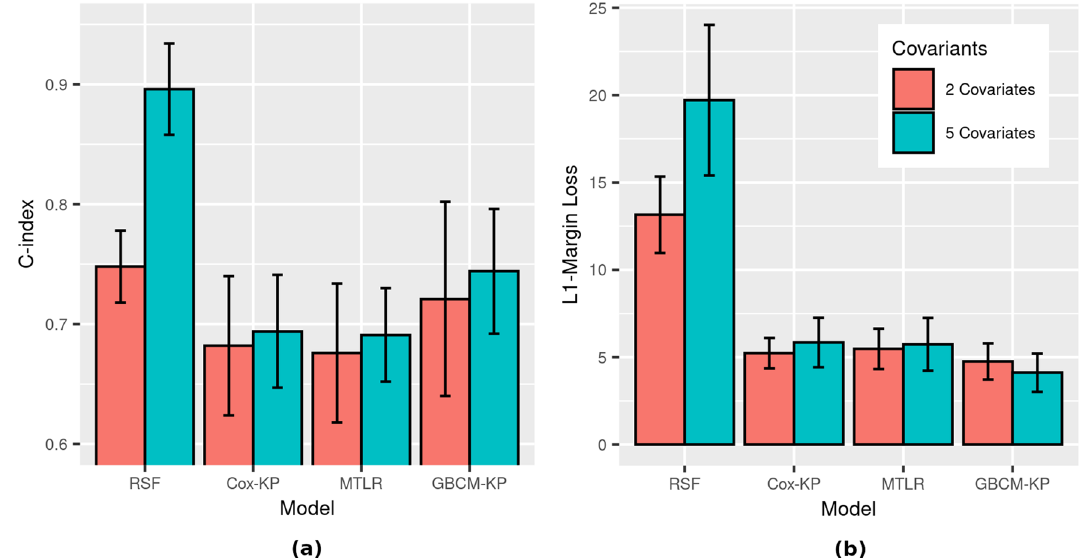
Figure 4. Survival prediction performance on dataset D2[h] (N = 1718) for hospital discharge as event of interest using two covariates (age, sex) versus five covariates (age, sex, chronic disease (binary indicator), longitude, and latitude—( a ) C-index, and ( b ) L1-Margin loss. The RSF model trained with five covariates in this experiment was not D-calibrated ( p -value ≈ 0) while the other seven models were D-calibrated ( p -value >